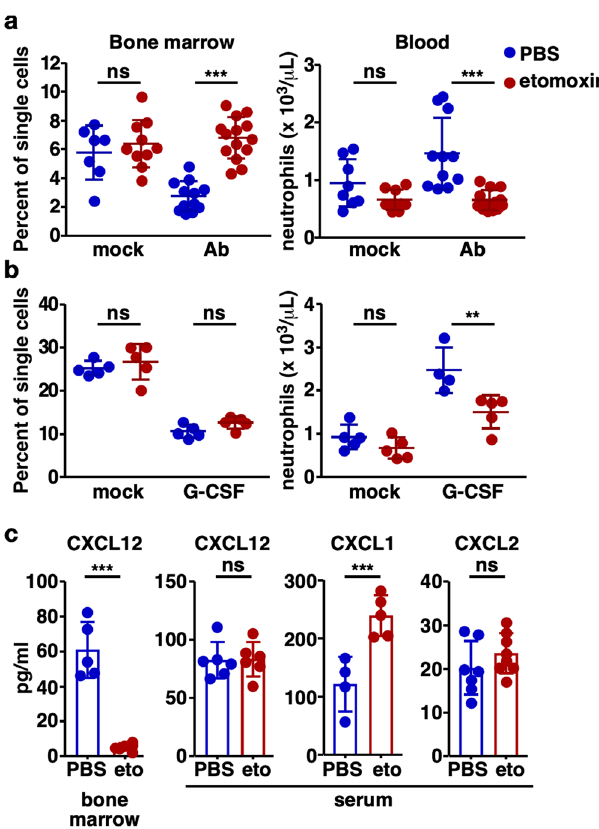
Fig. 4 Pharmacologic Cpt1a inhibition impairs neutrophil traf fi cking. a Mice were treated with etomoxir or PBS and mock-infected or